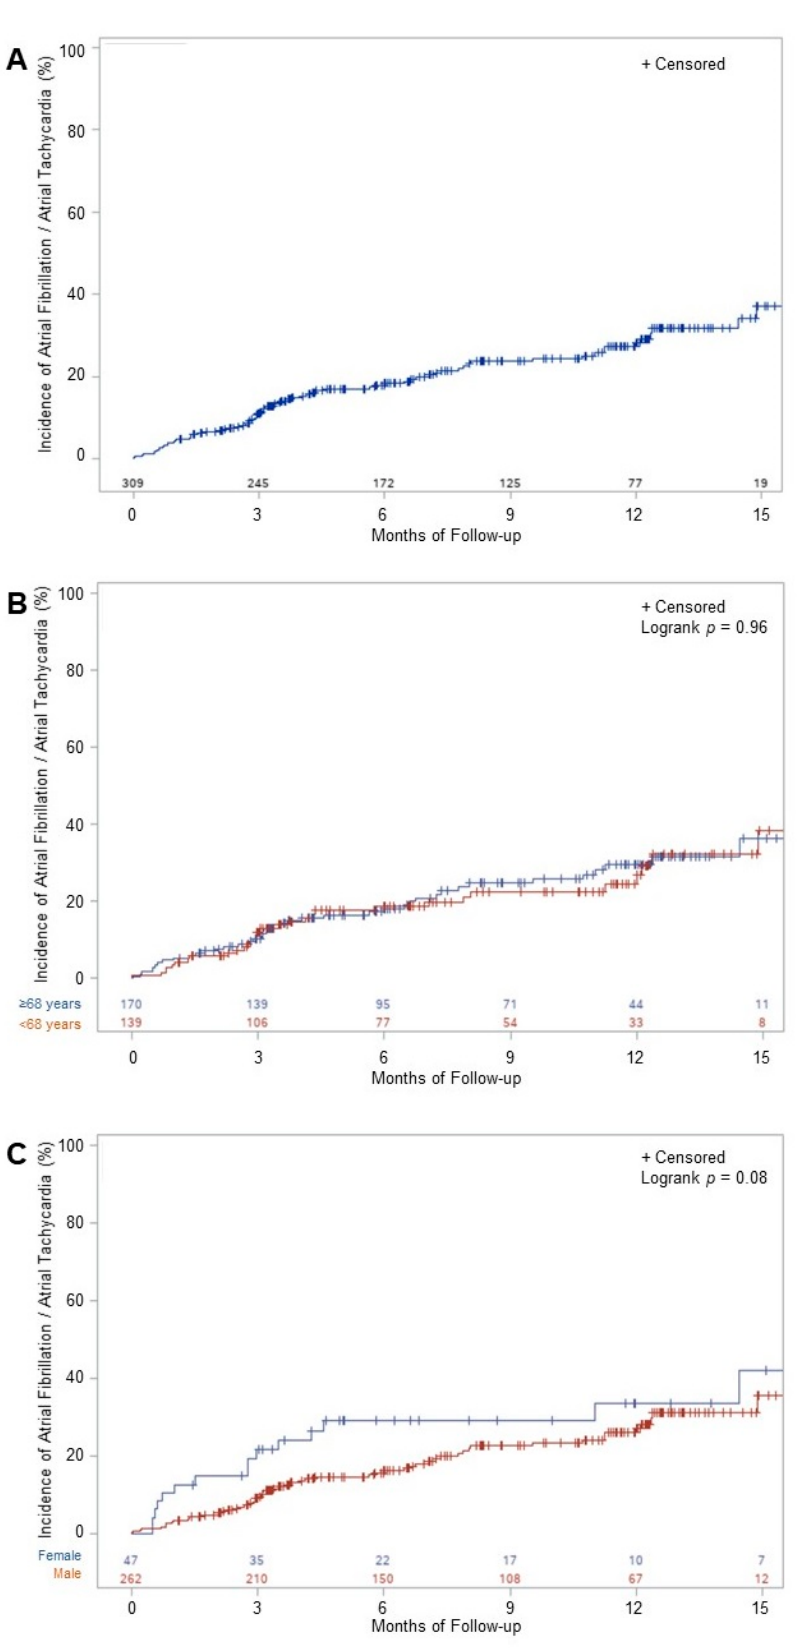
Figure 2. Incidence of atrial fibrillation or atrial tachycardia after ablation for CTI dependent atrial flutter overall ( A ), stratified by age ( B ) and sex ( C ). AF = atrial fibrillation.